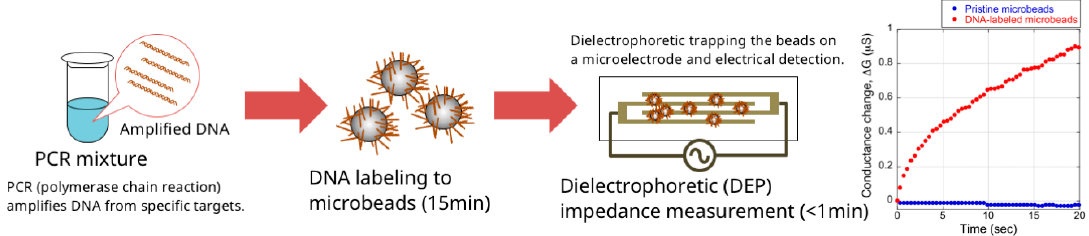
Figure 1. Schematic illustration of the microbead DEP-based DNA detection method.